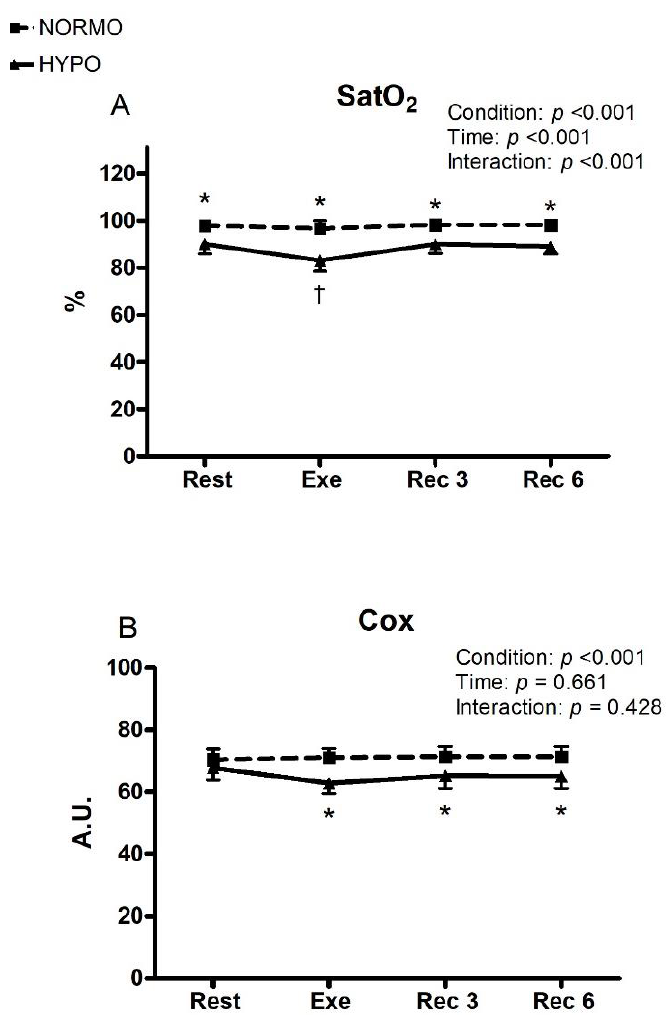
Figure 2. Changes in the level of peripheral blood O 2 saturation (SatO 2 , ( panel A ) during the sessions of exercise (Exe) in normoxia (NORMO) and in normobaric hypoxia with a FiO 2 of 13.5% (HYPO). Panel B shows changes in regional cerebral oxygenation (Cox) during the same tests. Values are mean with 95% confidence interval. N = 22. * = p < 0.05 between NORMO and HYPO at the same time point. † = p < 0.05 vs. rest, 3 min of recovery (Rec 3), and 6 min of recovery (Rec 6) of the same test.